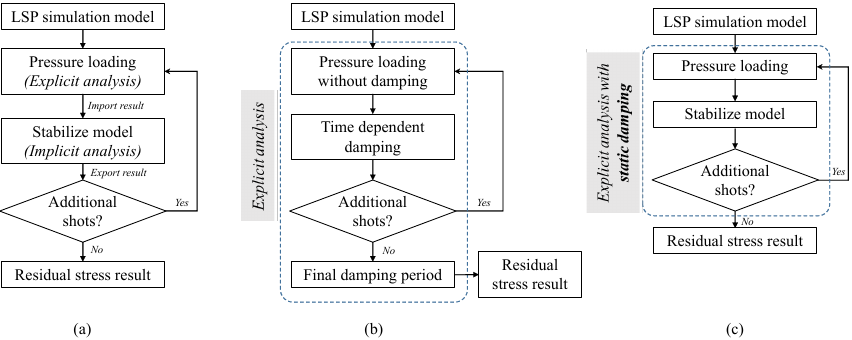
Figure 1. Analysis flow chart: ( a ) Typical explicit and implicit method; ( b ) SEATD explicit method; ( c ) Proposed static damping explicit